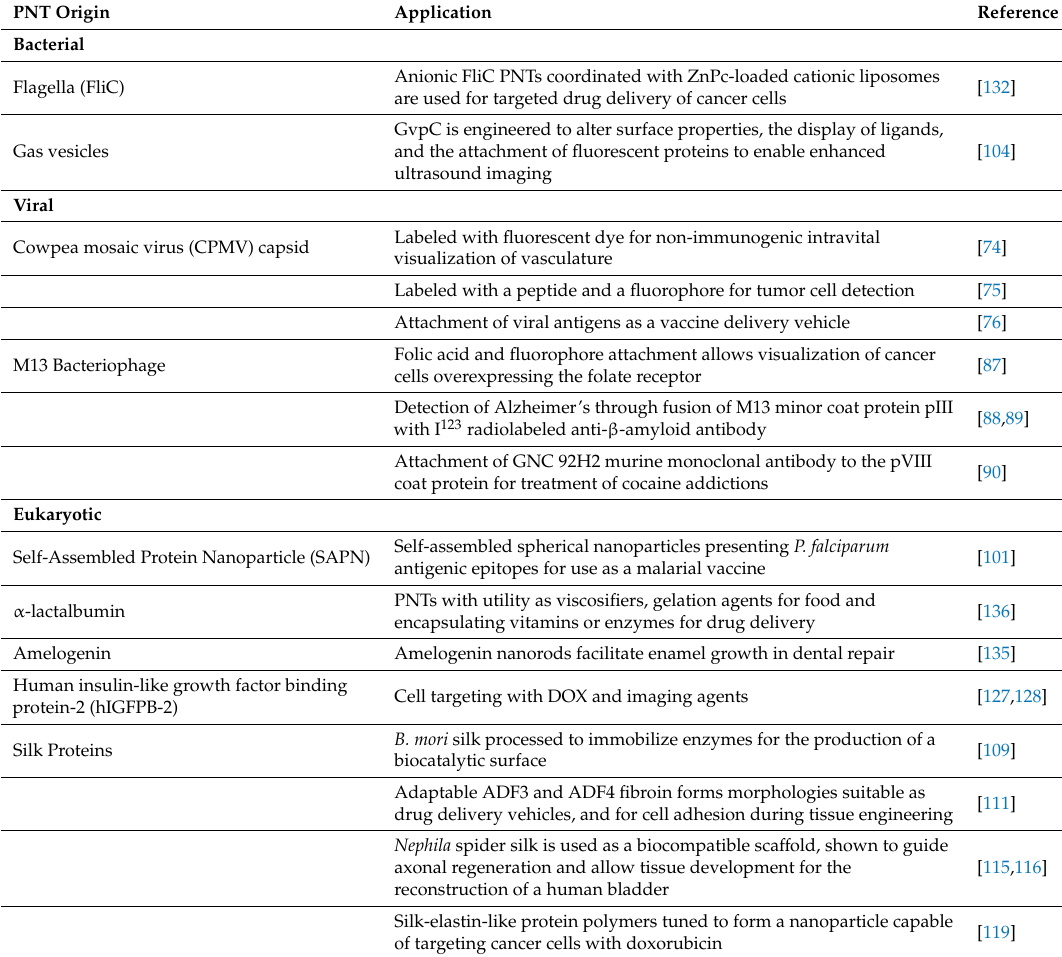
Table 1. Applications of PNTs in the medical, pharmaceutical and food